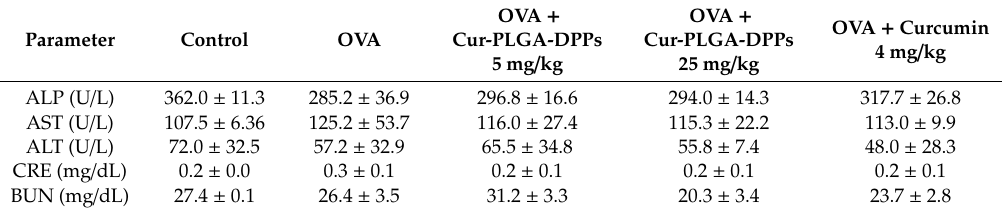
Table 2. Effect of administration of Cur-PLGA-DPPs on the biochemical parameters of the liver (ALP, AST, ALT) and kidney (CRE, BUN) damage markers. Values are presented as mean ± standard deviation ( n = 4).